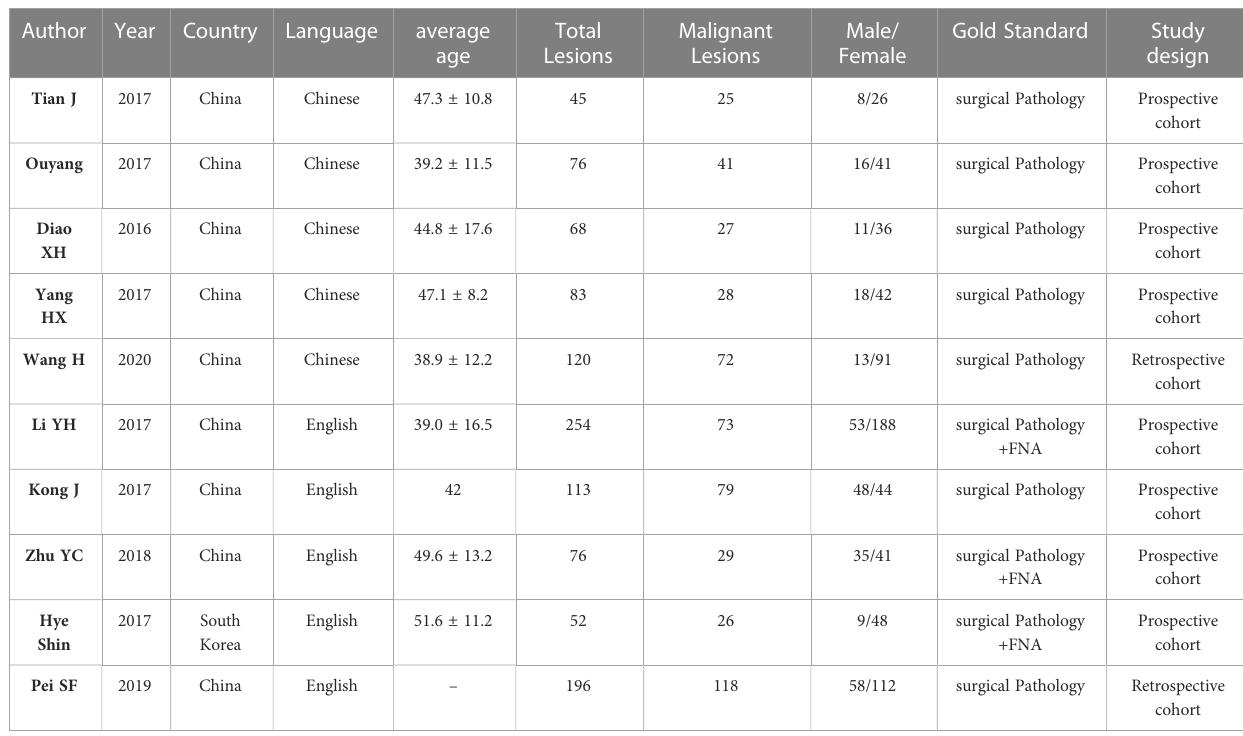
TABLE 1 characteristics of the included studies.